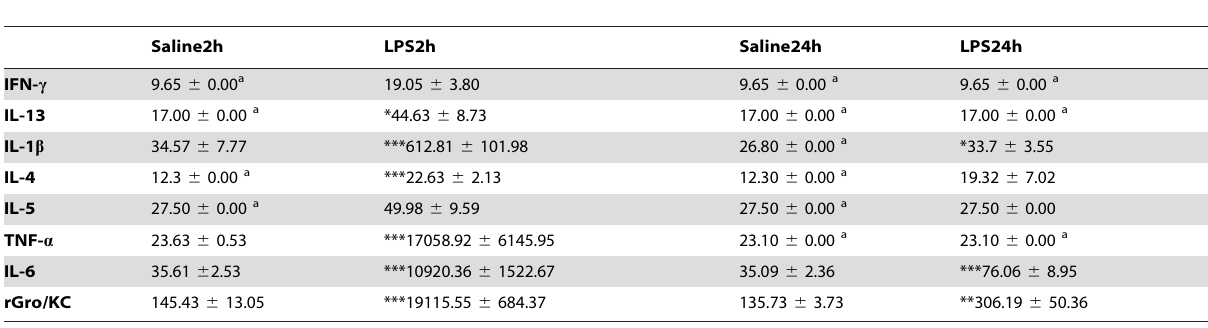
Table 1. Serum cytokine levels (pg/ml) 2 h and 24 h after LPS and saline treatment.